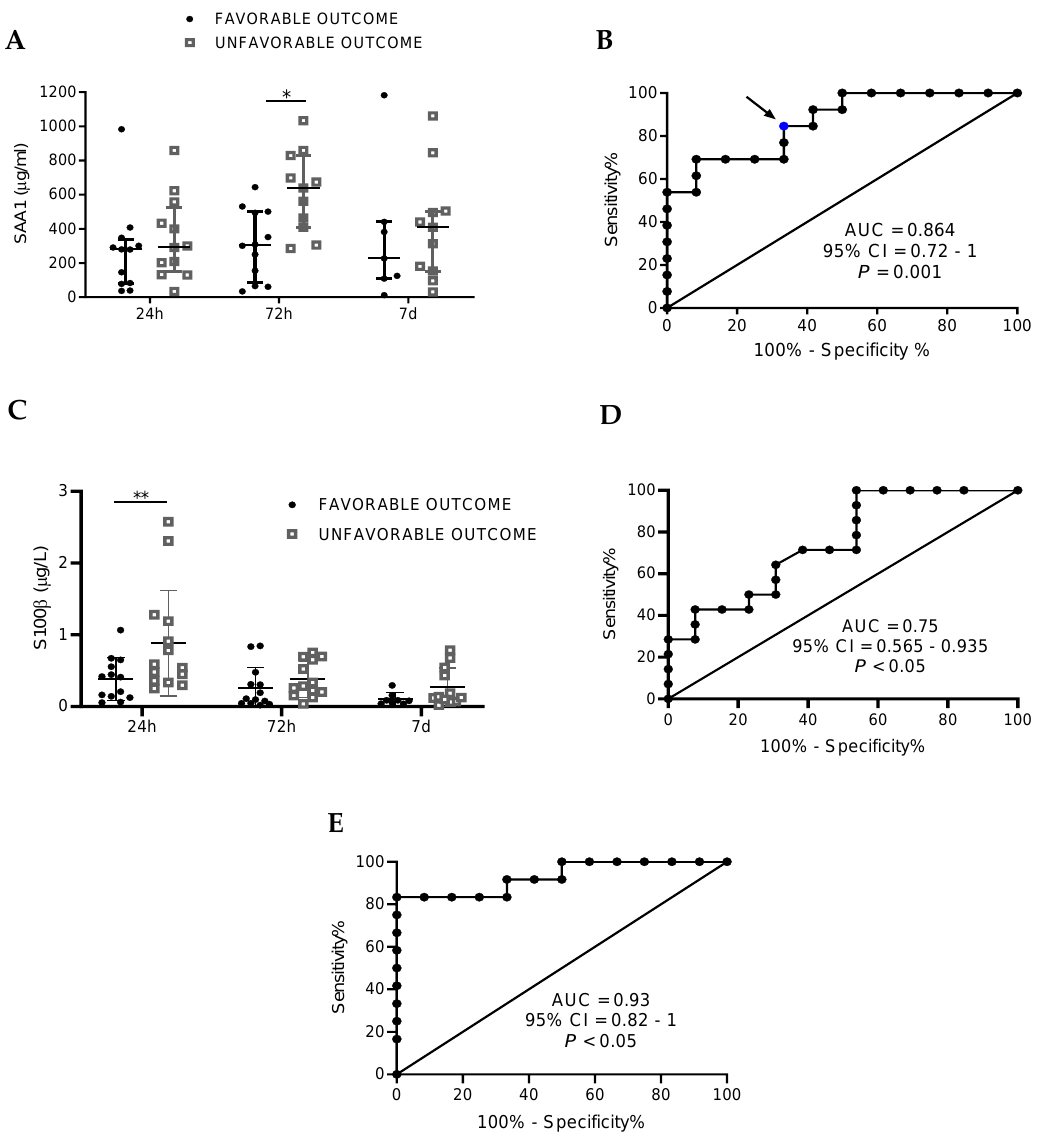
Figure 2. SAA1 levels 72 h after trauma predict TBI patients’ outcome at 6 months, S100B at 24 h, and a combination of both